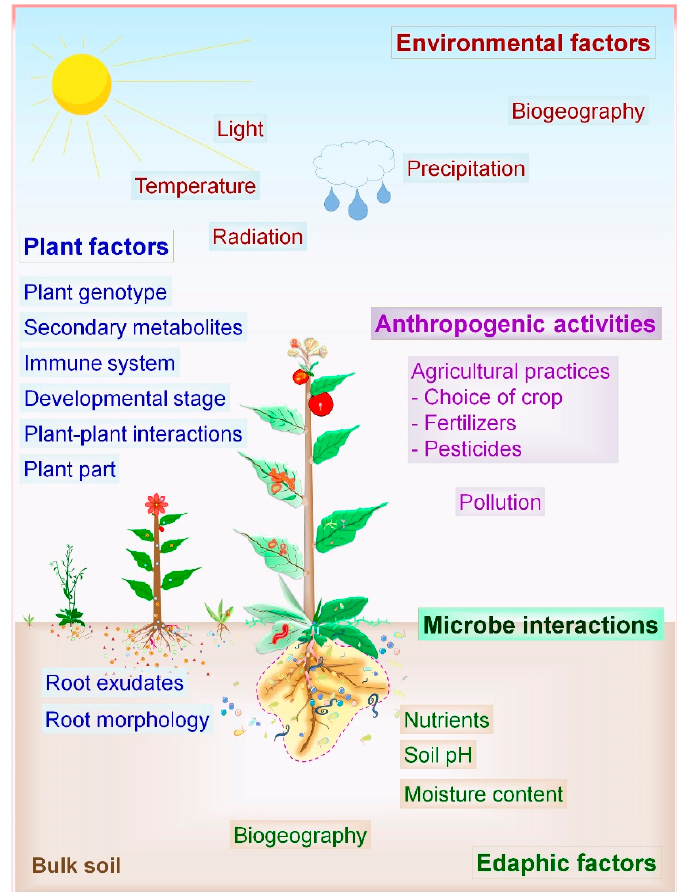
Figure 2. Driving factors of plant–microbe interactions. Environment-, soil- and plant-mediated factors determine the composition and structure of host microbiota. Furthermore, plant–plant, microbe–microbe, and plant–microbe interactions also impact the plant and soil